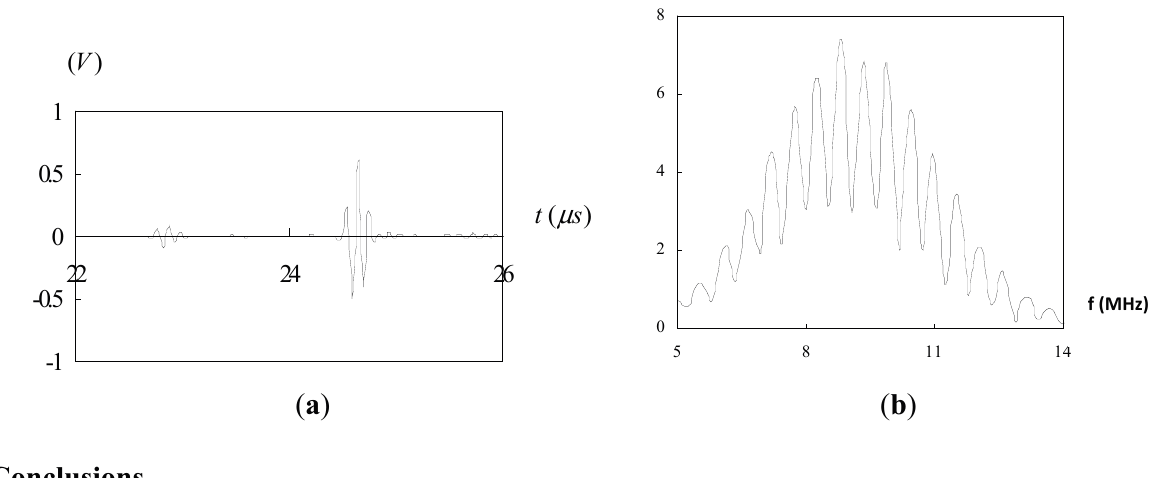
Figure 11. Reflection from a surface crack with 4 mm crack depth using 10 MHz longitudinal wave: ( a ) time domain; ( b ) frequency